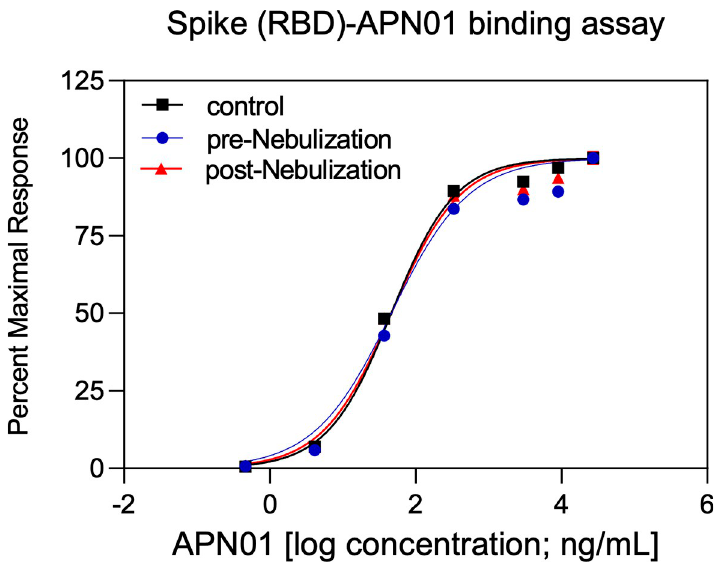
Fig 3. APN01 binding to the SARS-CoV-2 RBD is not altered by nebulization. Binding of increasing doses of APN01 to plate-immobilized RBD domain was assessed by ELISA. Curves depict pre-nebulization samples of APN01 (material remaining as liquid in the nebulizer cup), APN01 collected after nebulization (post-nebulization), and non- treated control APN01. For this experiment, APN01 was aerosolized at 2.5 mg/ml.